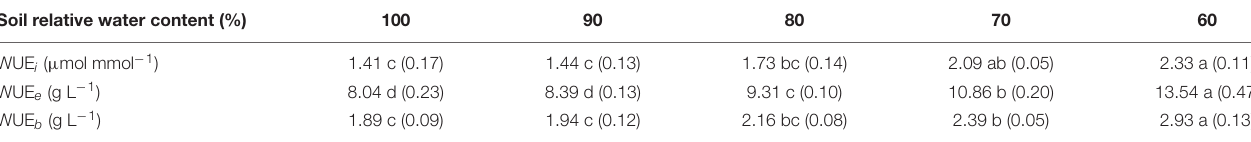
Means (n = 5) in the same column followed by different letters differ significantly at p ≤ 0.05, according to one-way ANOVA (standard error is shown in parenthesis). TABLE 5 | Instant water-use efficiency (WUE i , µ mol mmol − 1 ), economic water-use efficiency (WUE e , g L − 1 ), and biomass water-use efficiency (WUE b , g L − 1 ) in plants subjected to different water supplies. Soil relative water content (%)